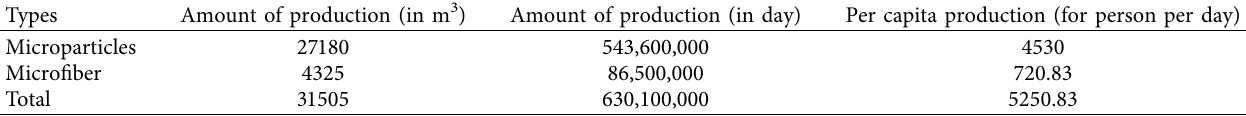
Table 7: Per capita production of microplastic particles according to the input efuent.